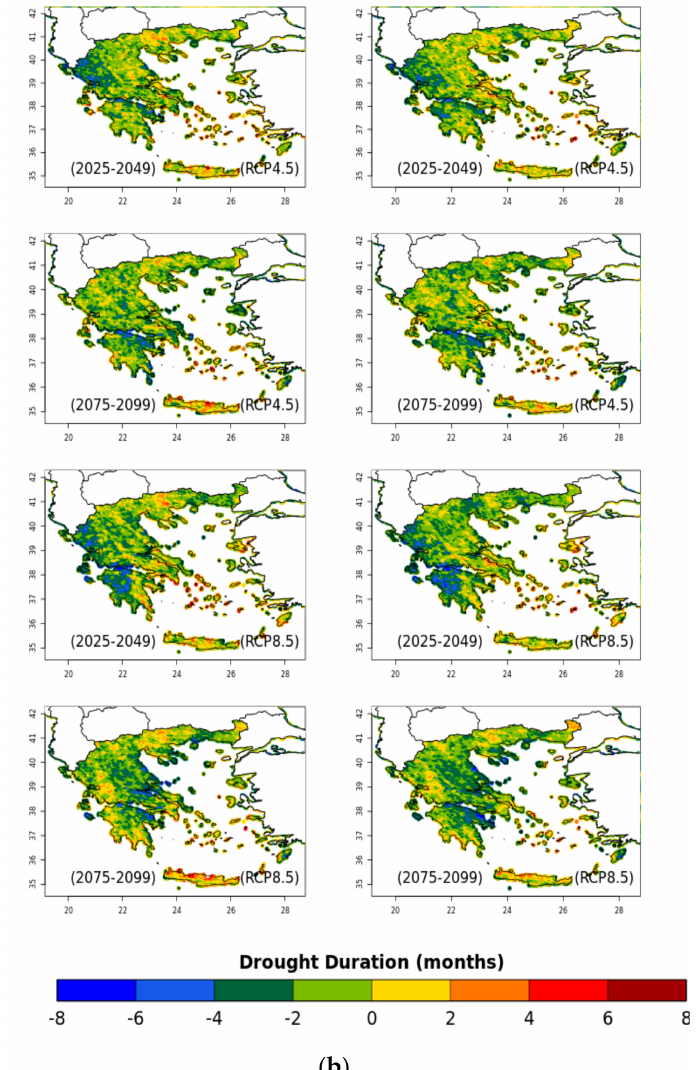
Figure 11. ( a ) Drought duration as the number of events in 25 years for the reference period (1980–2004) for the SPI and the SPEI indices computed at a 12-month timescale. ( b ) Changes in the duration for the 12-month SPI and SPEI for the near future period (2025–2049) and the far future (2075–2099) relative to the reference period (1980–2004) under RCP4.5 and